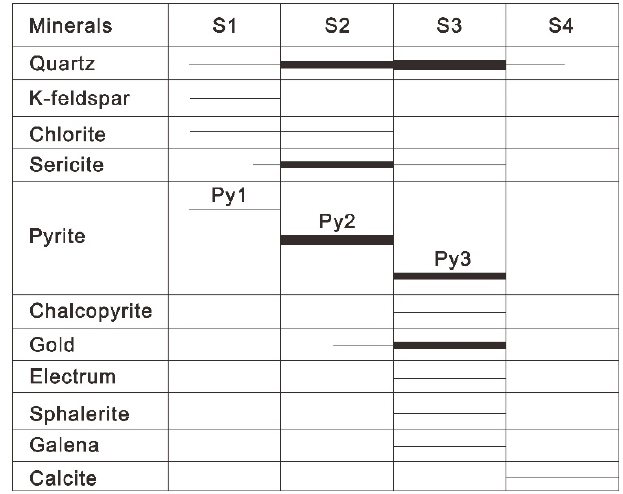
Figure 7. Paragenetic sequence of main minerals in the Longquanzhan gold deposit.